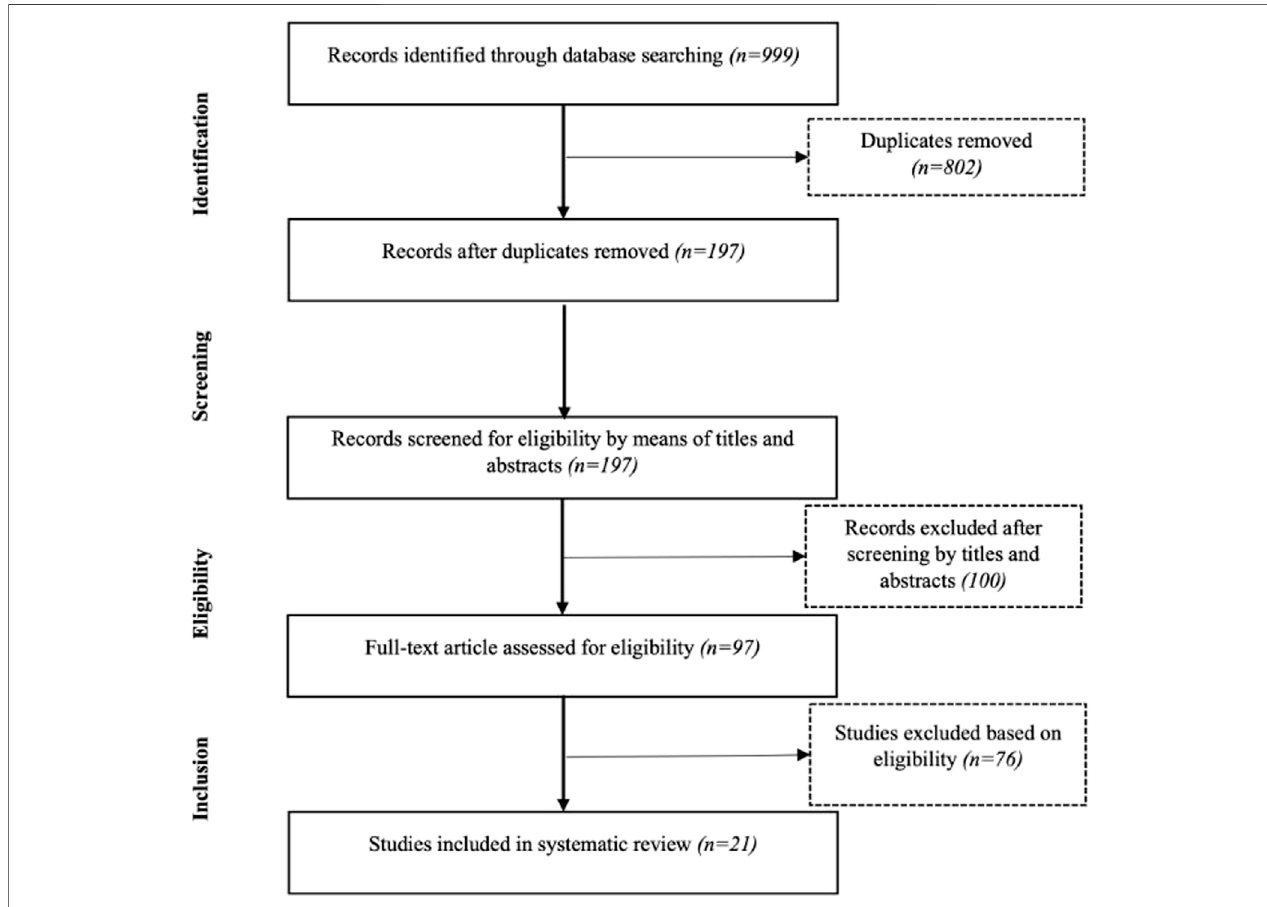
FIGURE 1 | Flow diagram of included and excluded studies included in this systematic review using the recommendations in the Preferred Reporting Items for Systematic reviews and Meta-Analyses (PRISMA) statement.